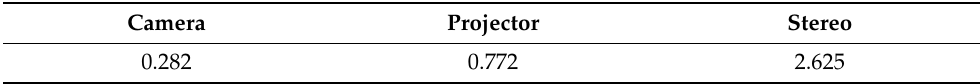
Table 5. RMS reprojection error of the second